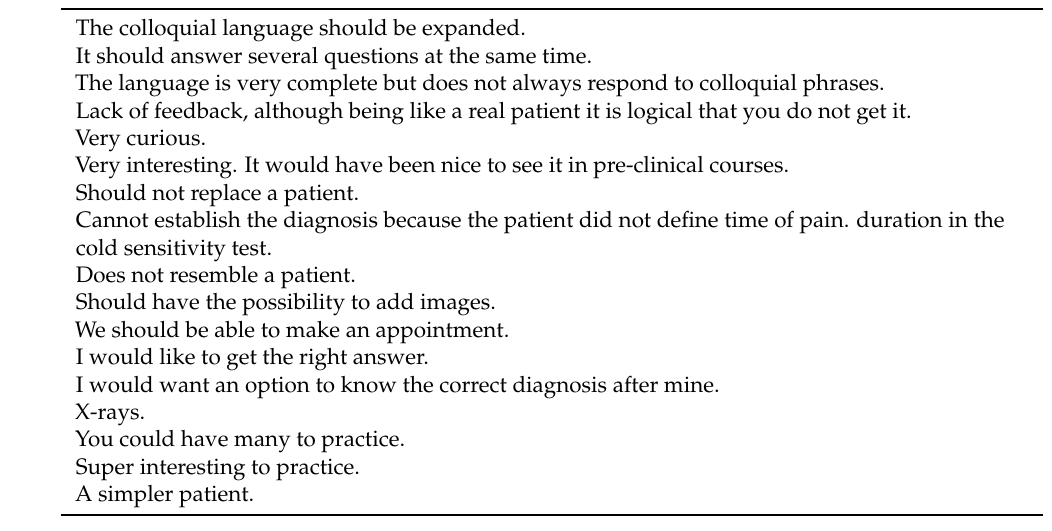
Table 9. Responses to the free text field in which students could add their impressions after the